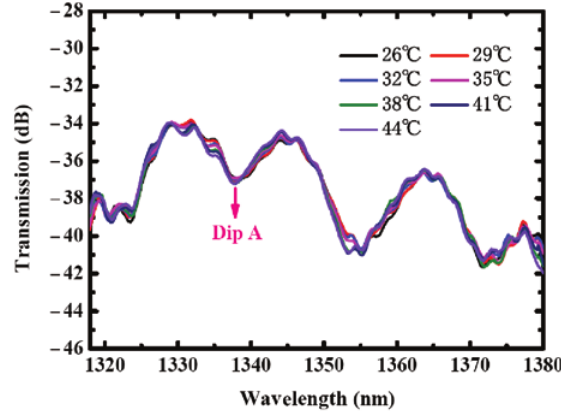
Figure 6: Transmission spectral evolutions of the all-solid WAF under different temperatures.